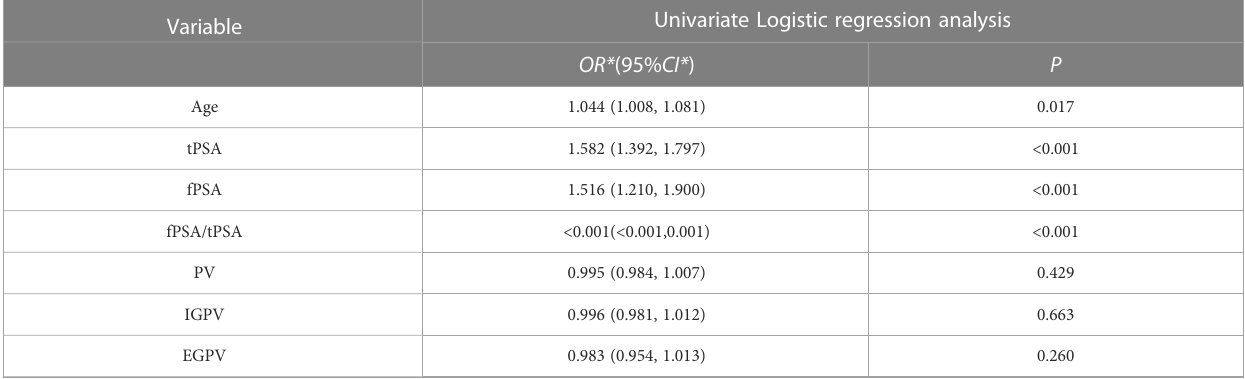
TABLE 1 Logistic regression analysis of variables related to clinically signi fi cant prostate cancer.